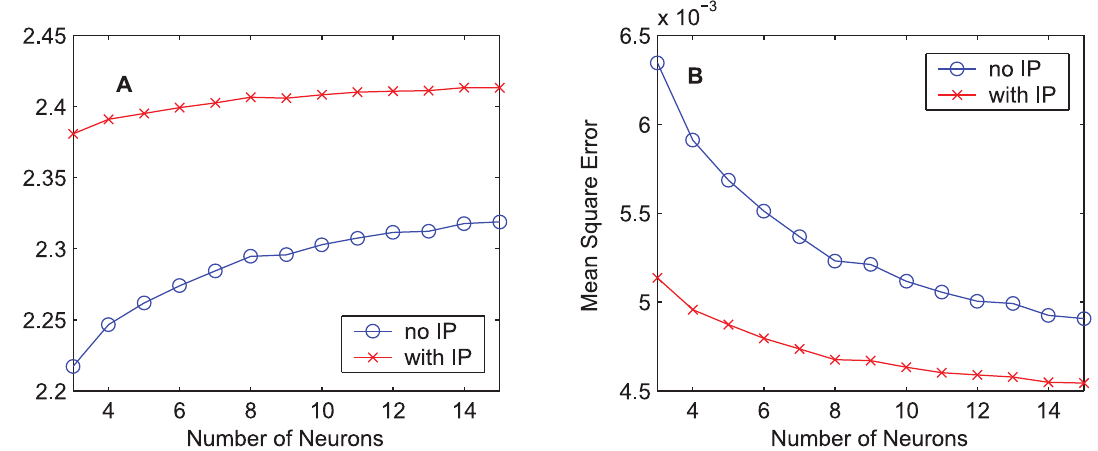
Figure 10. Relation between the training result and the number of hidden neurons of the FNN. Training results after 1000-epoch training for the case of the training data set ‘‘MG’’ are presented. The circle markers denote the results obtained by the MEE algorithm, and the cross markers denote the results obtained by the synergistic algorithm. (A) Results of the quadratic information potential. (B) Results of the mean square error.